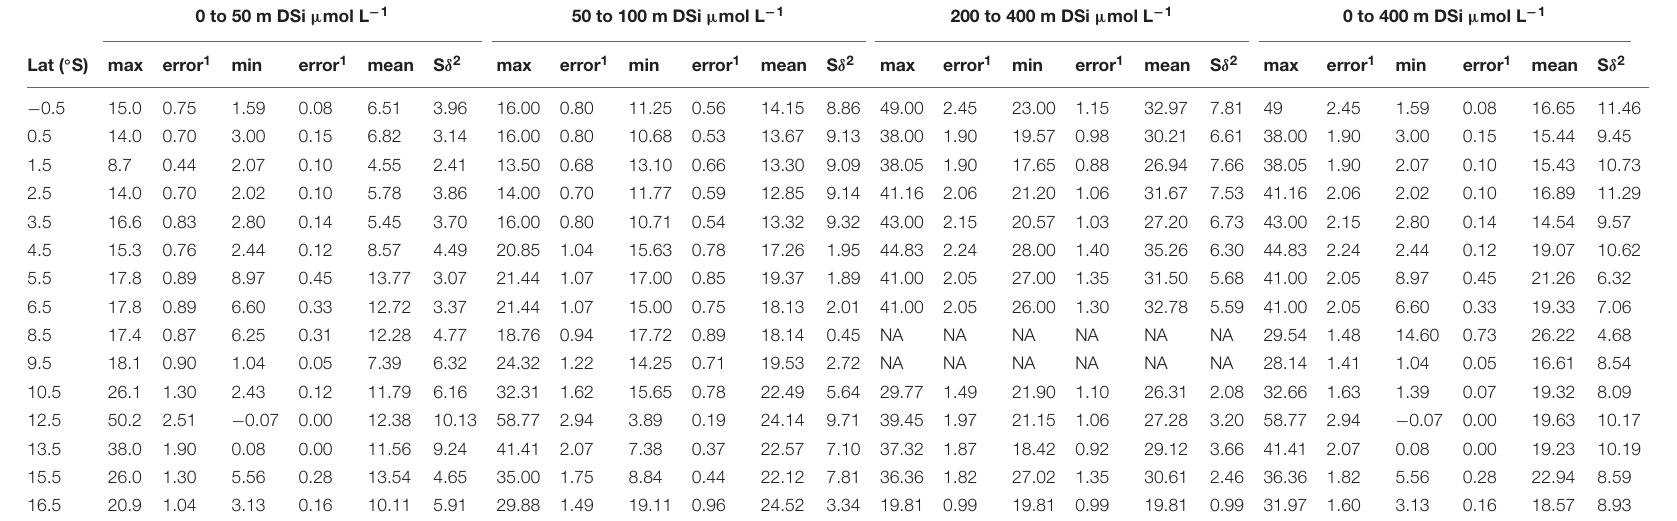
TABLE 2 | DSi concentrations ( µ mol L − 1 ) versus latitude for all water stations presented in Figure 2